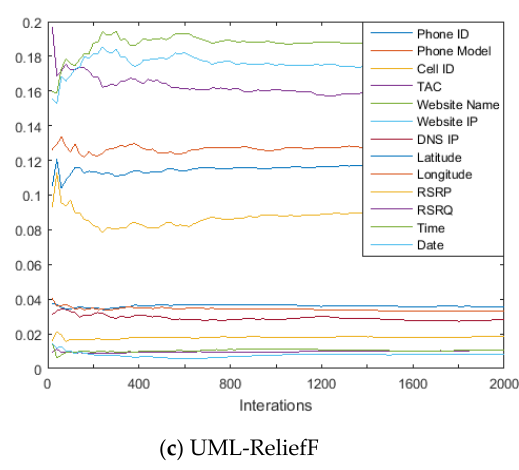
Figure 3. Convergence of normalized weights for the three FS algorithms.